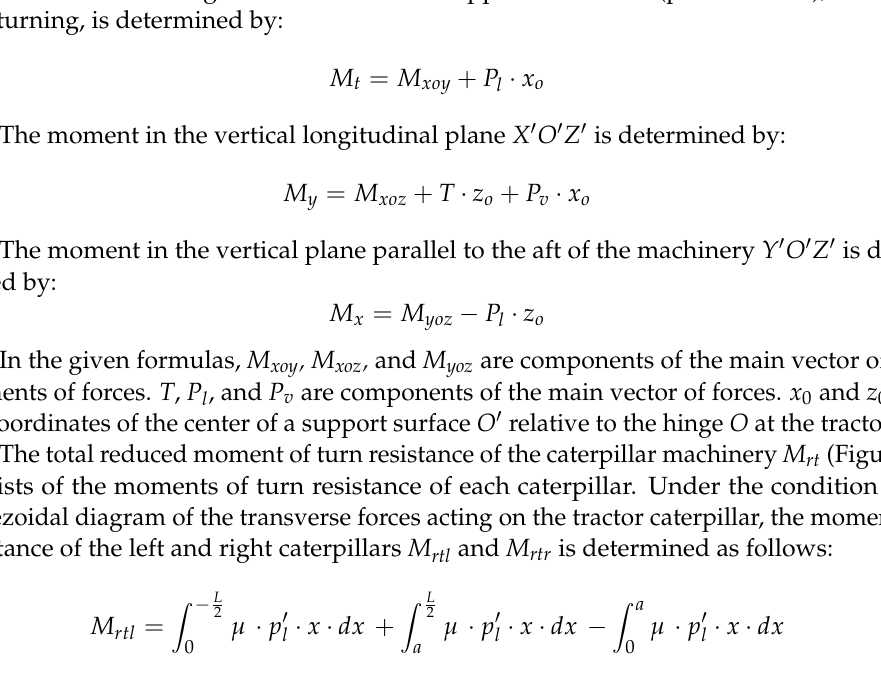
Figure 4. Scheme of determining the moment of resistance of the tractor turn.